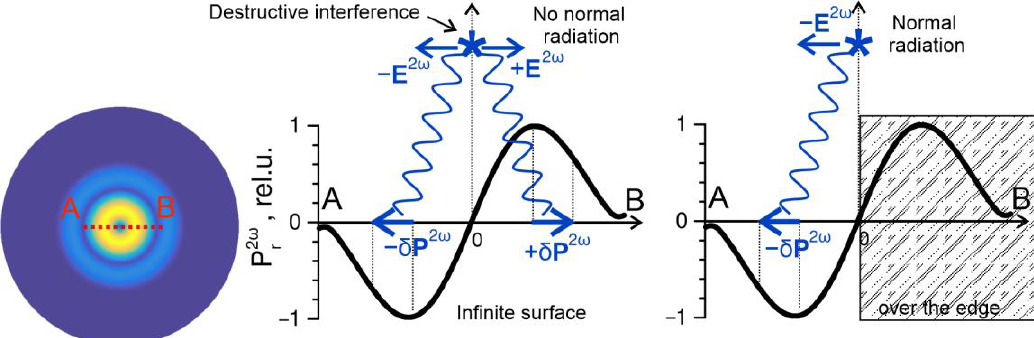
Figure 4. Illustration of the appearance of normal radiation due to the effect of the edge.